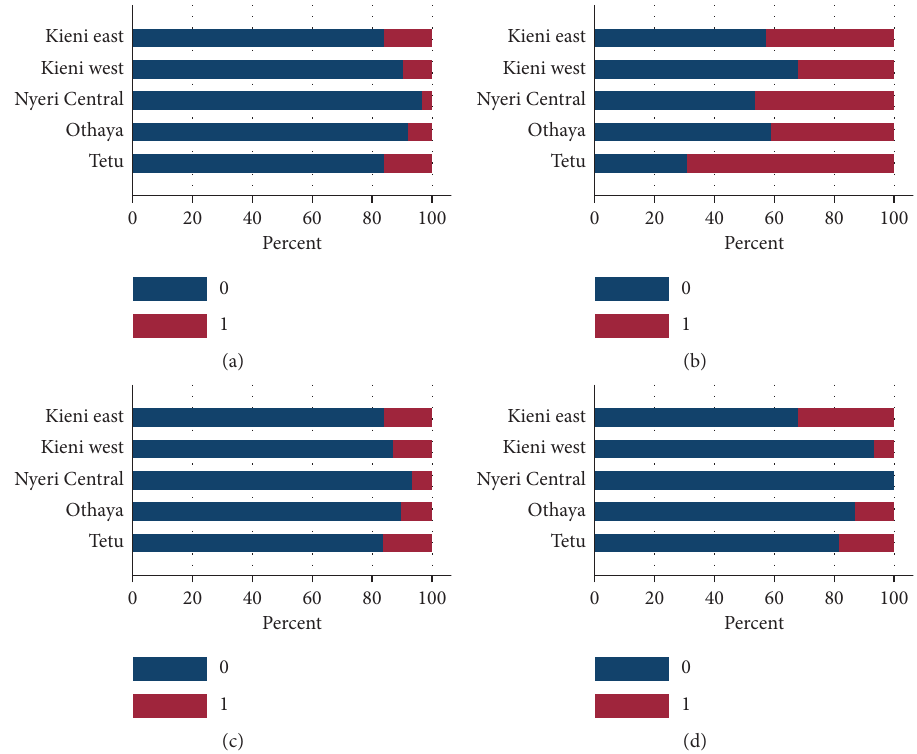
Figure 10: Clinical signs as observed by farmers in different subcounties. 0 � not observed; 1 � observed. Percentages are per clinical sign/ observation. Most respondents were able to identify poor growth as a clinical sign of disease. (a) Decreased feed. (b) Poor growth. (c) Stationary. (d) Abnormal swimming.